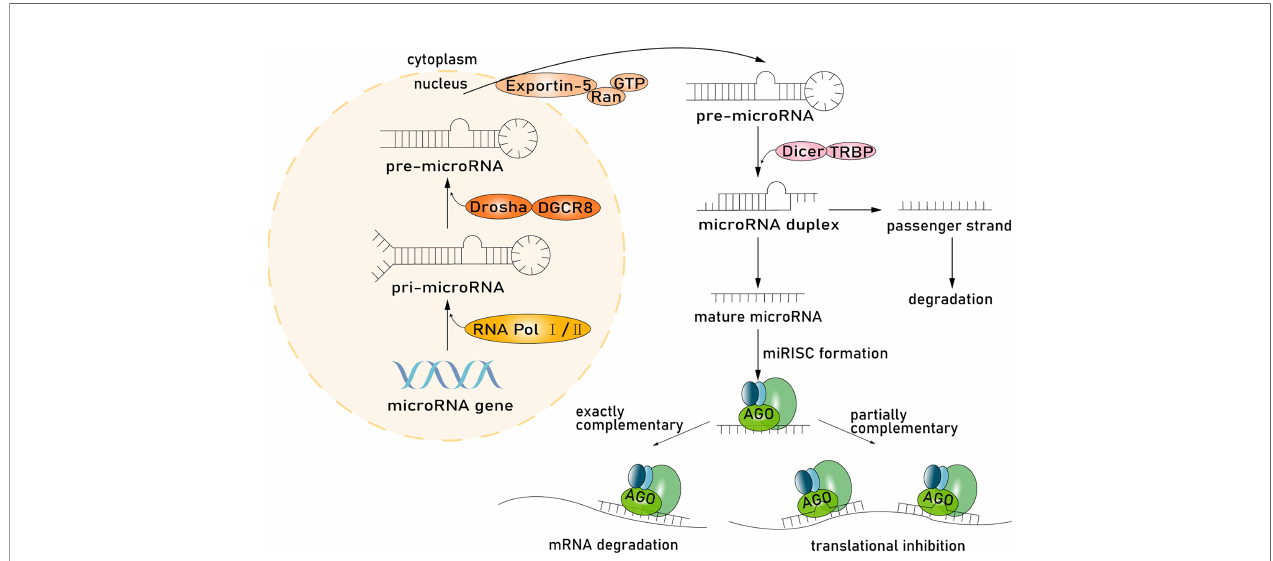
FIGURE 1 | miRNA processing pathway. Host-derived miRNAs are synthesized in the nucleus and processed and then function in the cytoplasm. miRNA genes are transcribed into pri-miRNA through RNA polymerase II or RNA polymerase III subsequently cleaved by the microprocessor complex Drosha-DGCR8. The resulting precursor hairpins, the pre-miRNAs, are exported from the nucleus to the cytoplasm by exportin-5 – Ran-GTP. In the cytoplasm, pre-miRNAs are cleaved into mature length by the Dicer in complex with TRBP. Functional strands of mature miRNAs are assembled with AGO proteins and a glycinetryptophan repeat-containing protein of 182 kDa (GW182), and then miRISC mediating target mRNAs silencing are recruited, whereas passenger strands are degraded. miRNAs regulate gene expression through two mechanisms. First, miRNA, with a wide range of complementary base pairs with mRNA, will guide miRISC to degrade mRNA, resulting in the instability or suppression of translation. Second, if miRNA and mRNA have partially complementary sequences, the miRISC will inhibit mRNA translation through the AGO